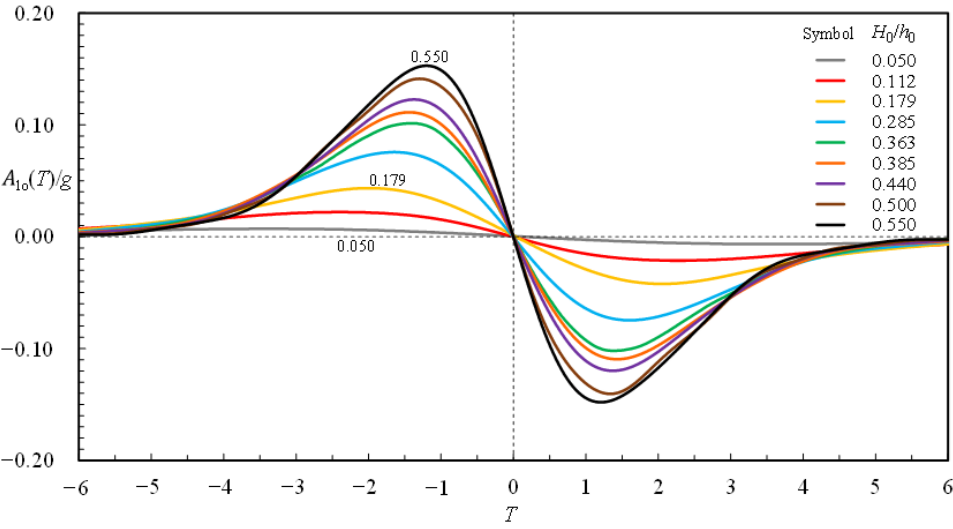
Figure 15. A comparison of temporal variations in the non-dimensional local acceleration for H 0 / h 0 = 0.050–0.550.